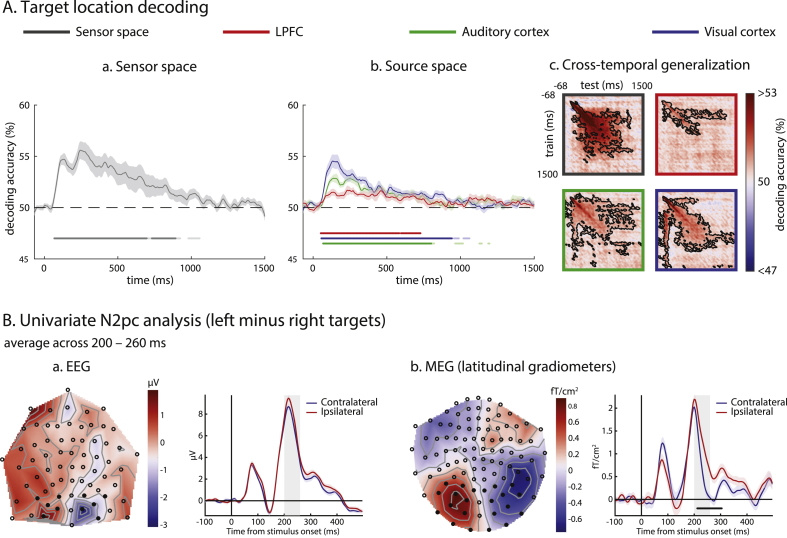
Coding of target location in 3-item displays. (A) Decoding of target location during presentation of 3-item displays, i.e., whether the item corresponding to the cue is in the left, right, or bottom position. Format as in Fig. 3. Location decoding was strongest in the visual cortex. (B) Univariate N2pc ERP/ERFs across (a) EEG electrodes and (b) latitudinal gradiometers. Latitudinal gradiometers are presented because their orientation around the helmet means that contralateral asymmetries in the magnetic flux gradient are expressed analogously to the EEG topography (Mitchell and Cusack, 2011; Kuo et al., 2016). Topographies are averaged across 200–260 ms (marked in grey on the time-courses). Time-courses are averaged across posterior sensors contralateral and ipsilateral to the target (highlighted on the topographies), with black dots indicating a significant difference (p < 0.05) after TFCE with permutation testing.